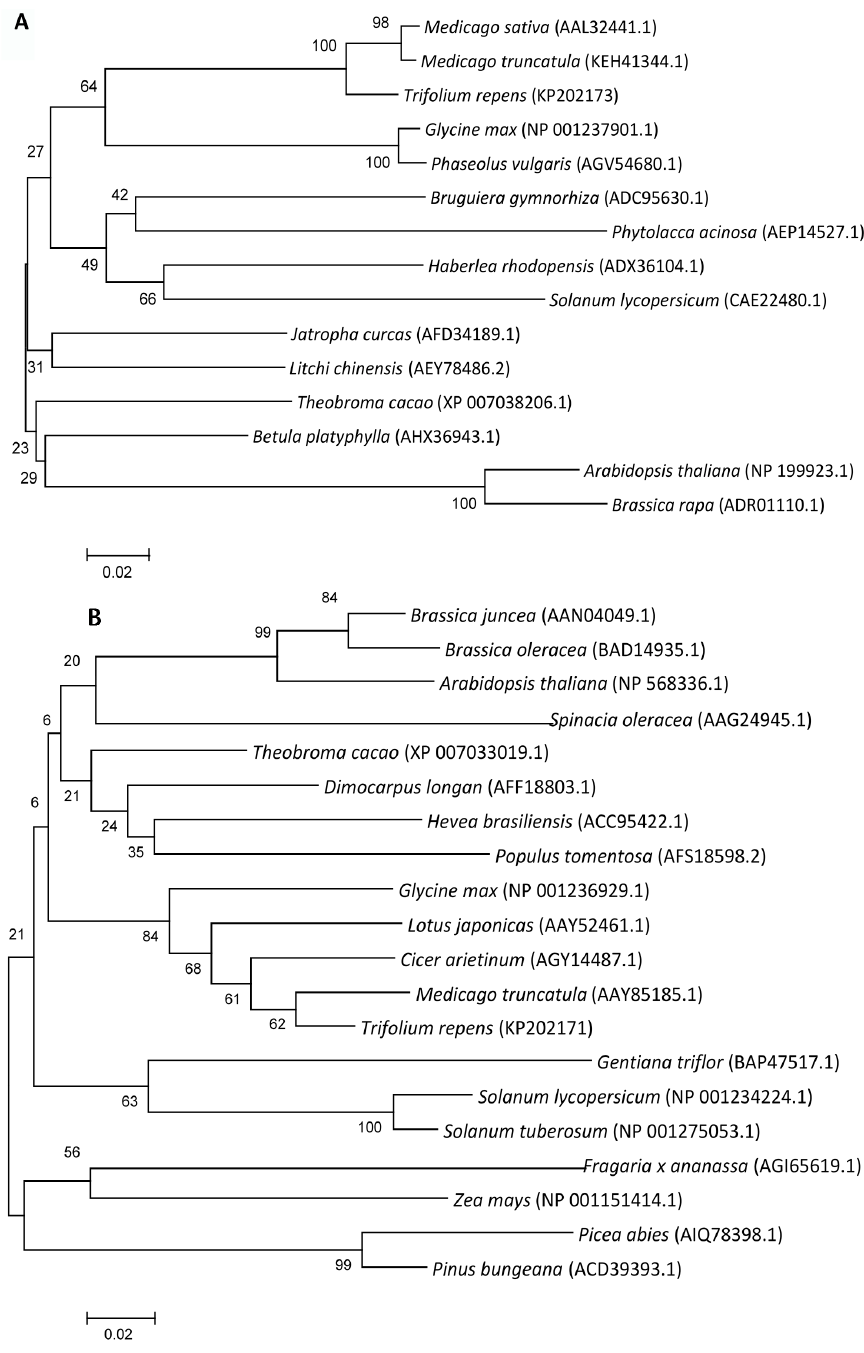
Figure 1. Cont. Figure 1.